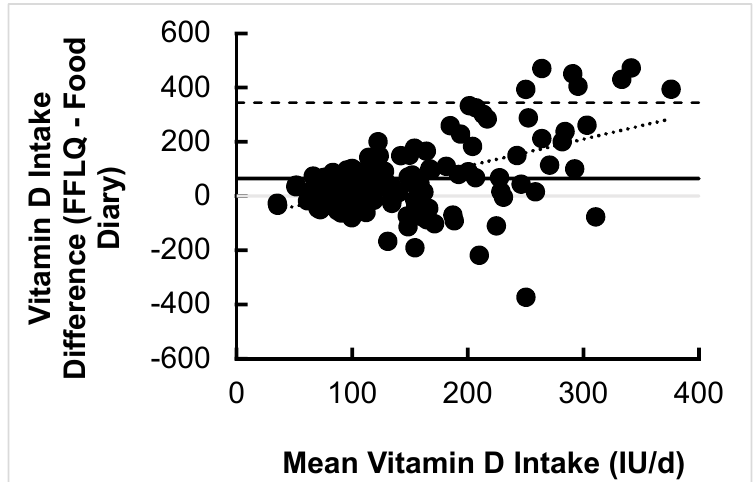
Figure 1. Bland–Altman plot demonstrating the association between average vitamin D intake from food sources estimated from the FFLQ and 7-day food diaries and the difference between both methods. The mean difference = 64.2 IU, with dashed lines illustrating the upper and lower limit of agreement after adding a ±1.96-fold standard deviation.